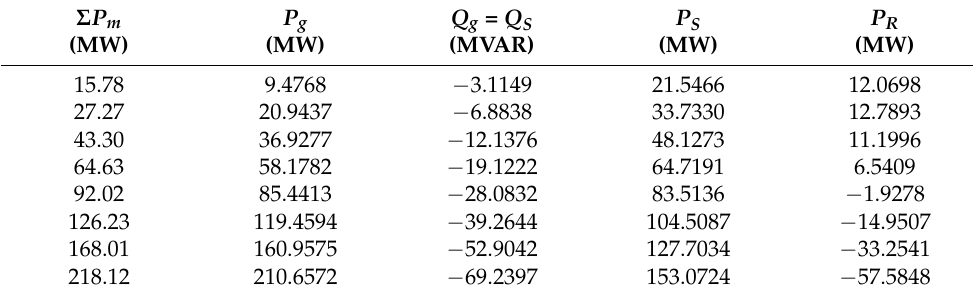
Table 13. DFIG power flow (PF = 0.95 lagging).